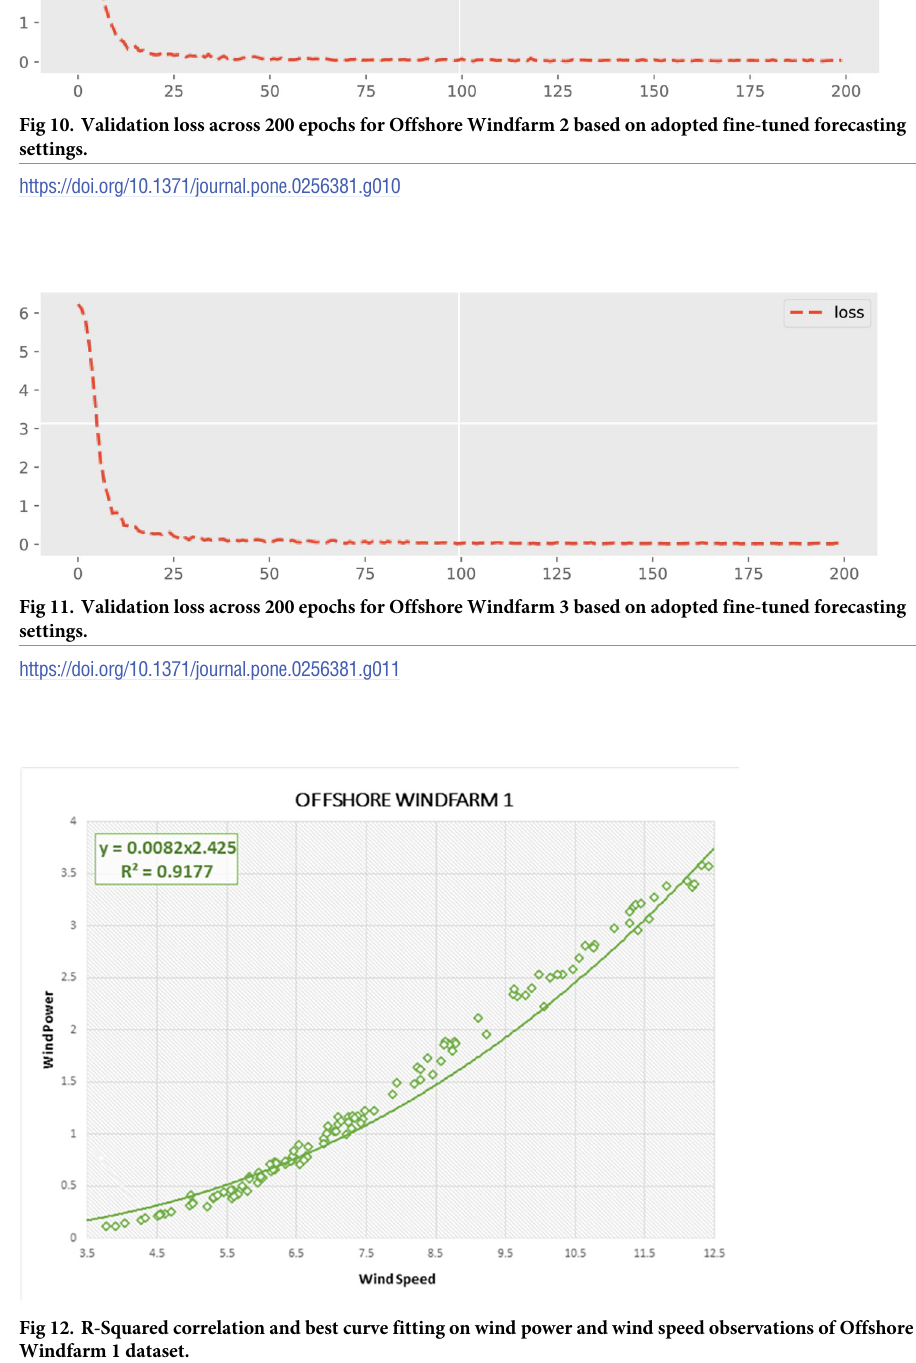
PLOS ONE | https://doi.org/10.1371/journal.pone.0256381 August 20,